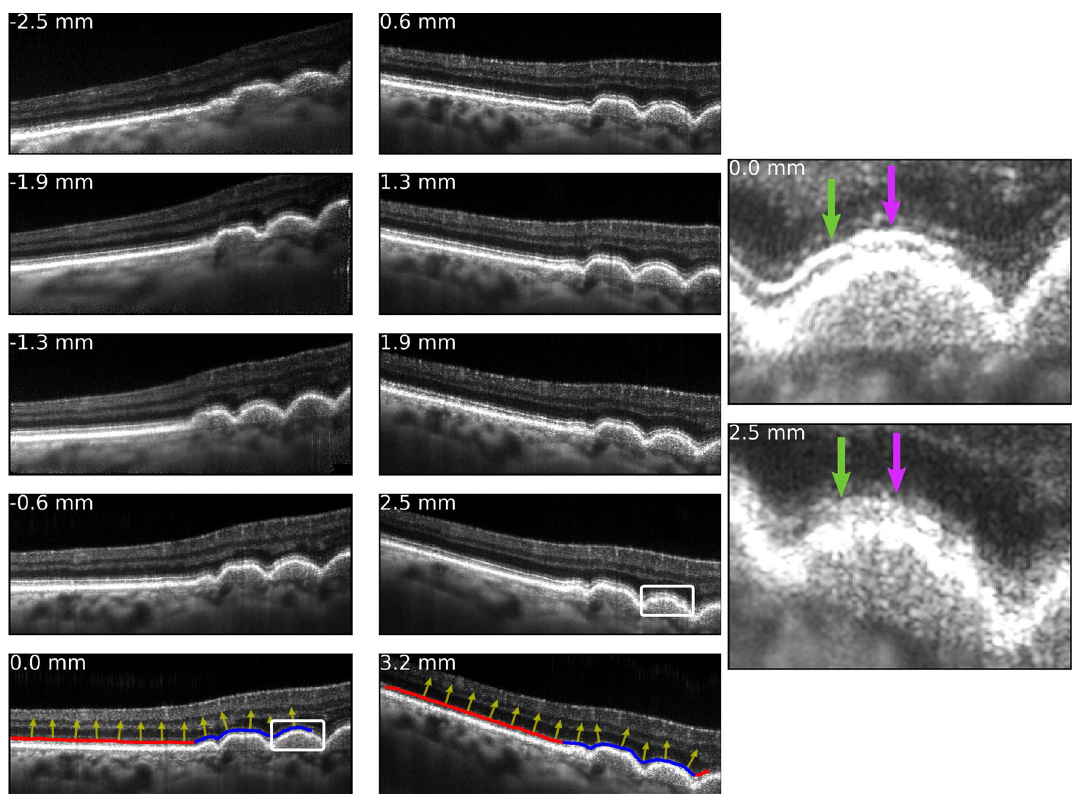
Figure 4. Illustration of the directional effect on OCT image and concept of the analytical approach. The left and center columns are B-scans of a drusen-containing retinal region acquired through different locations in the pupil. The OCT images subtend 6.0 ◦ of visual angle, or approximately 1.8 mm at the retina. At the edges of the pupil the path length variation across the scan angle is maximized, explaining the visible tilt of the retina. In B-scans acquired near the center of the pupil, the retina appears flat. The approximate pupil position, relative to center, is indicated on each image. At this location this subject has several large (200 to 300 µ m ) drusen, visible at the right edge of each image. The appearance of the outer retinal bands is affected by angle of illumination, and this is especially visible where the bands are deformed by the underlying drusen (green and purple arrows). Images of one druse acquired at 0.0 mm and 2.5 mm are magnified at the right, illustrating the qualitative directional effects. Incident angle was computed across the scan range, by fitting the IS/OS band and computing the tangent to the fitted curve at all points. This process is illustrated in the bottom images of the left and center columns. Nominally normal and drusen-affected portions of the IS/OS band are colored red and blue,